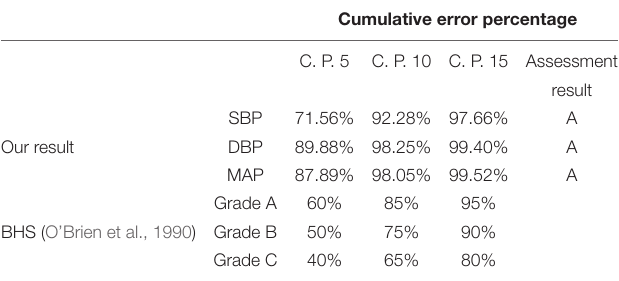
TABLE 3 | Comparison of estimated BP values between our work and BHS